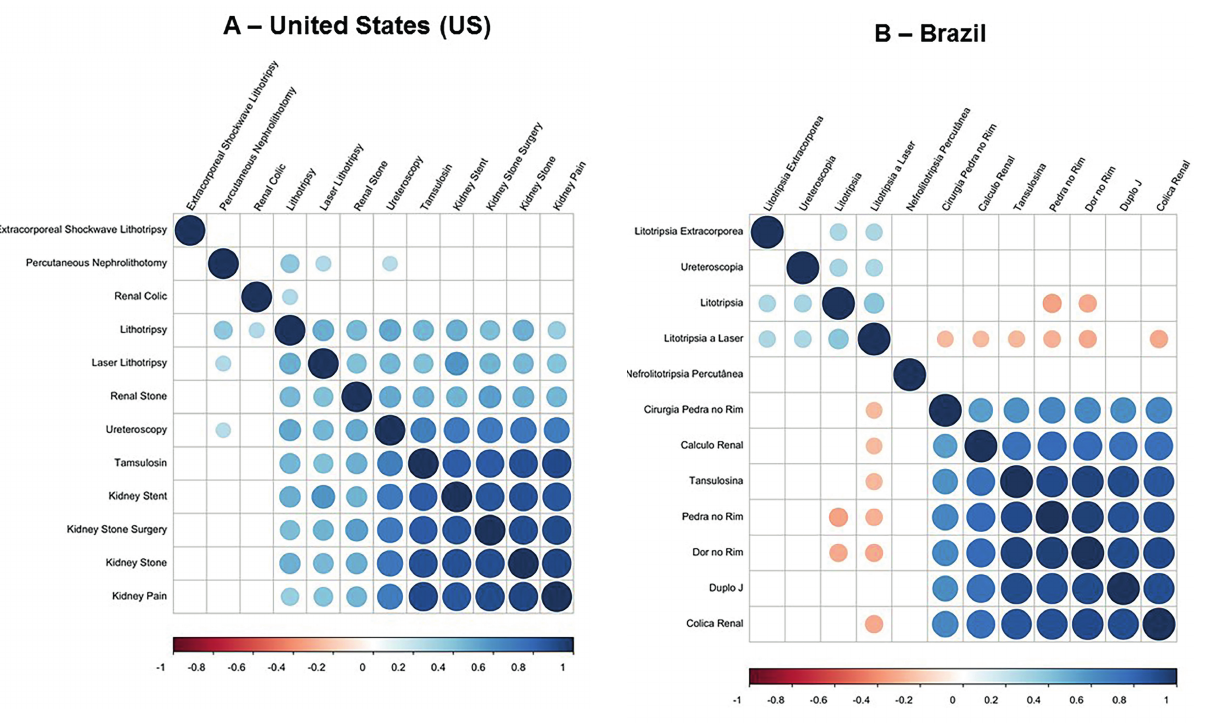
Figure 2 - Correlation evaluation between stone-disease related terms searched on Google Trends platform in the United States - US (A) and Brazil